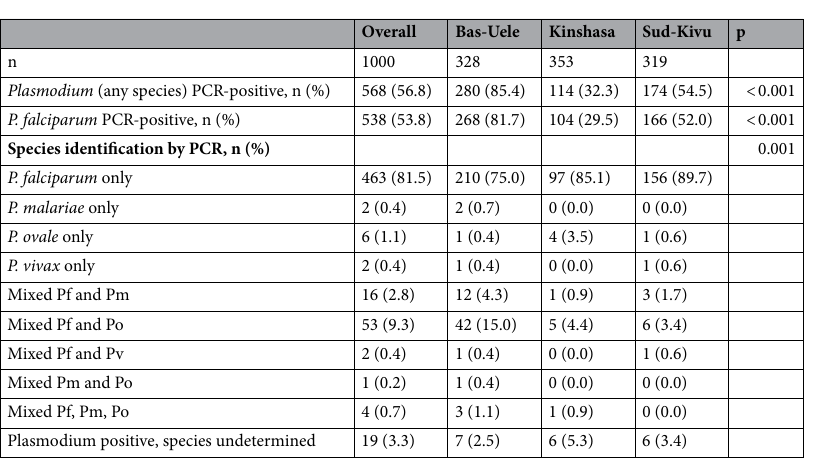
Table 3. Species identification by PCR among subjects with symptomatic malaria. Results of Plasmodium genus and species-specific 18S rRNA real-time PCR assays. Kruskal–Wallis p values are included for province- wise comparisons. Pf P. falciparum, Pm P. malariae, Po P. ovale, Pv P.